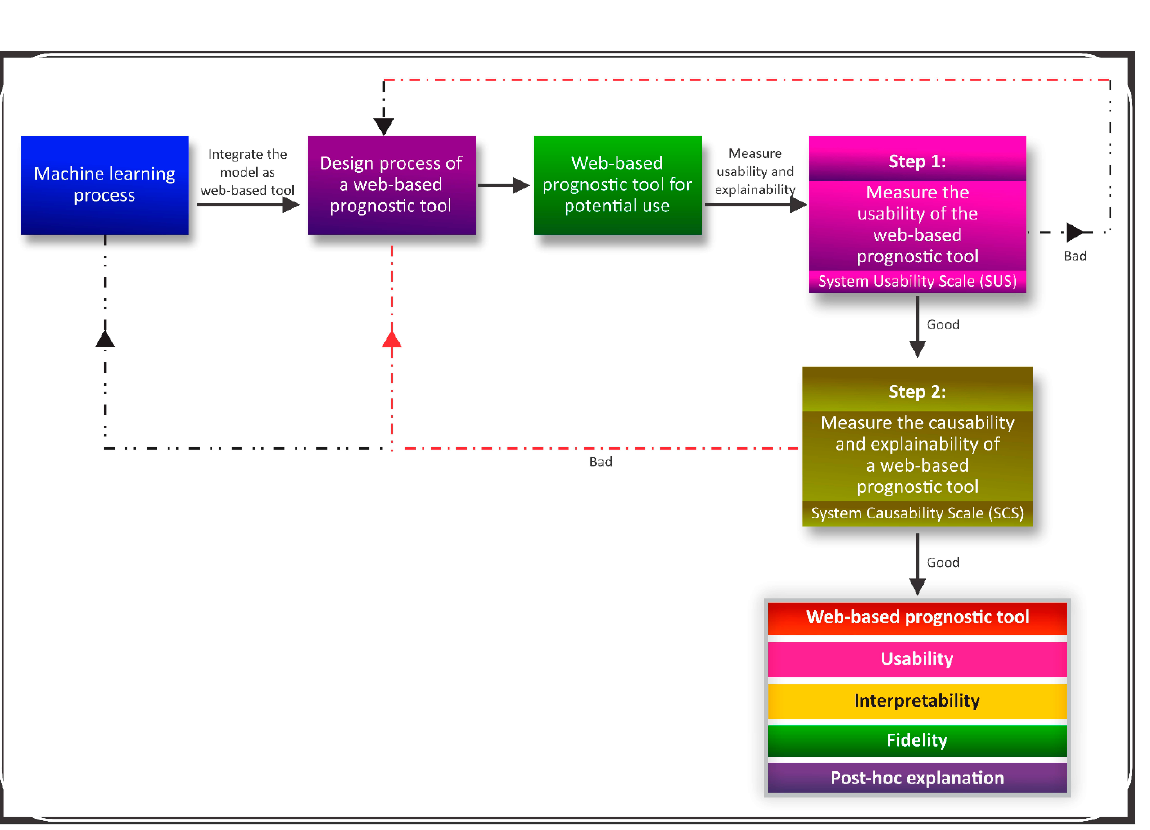
Figure 5. Framework for post hoc explainability of a web-based prognostic tool.